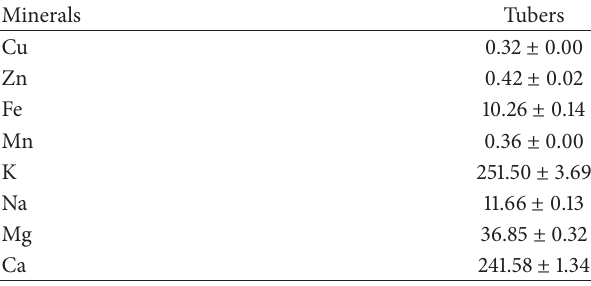
Table 2: Mineral contents of O. japonicus tubers